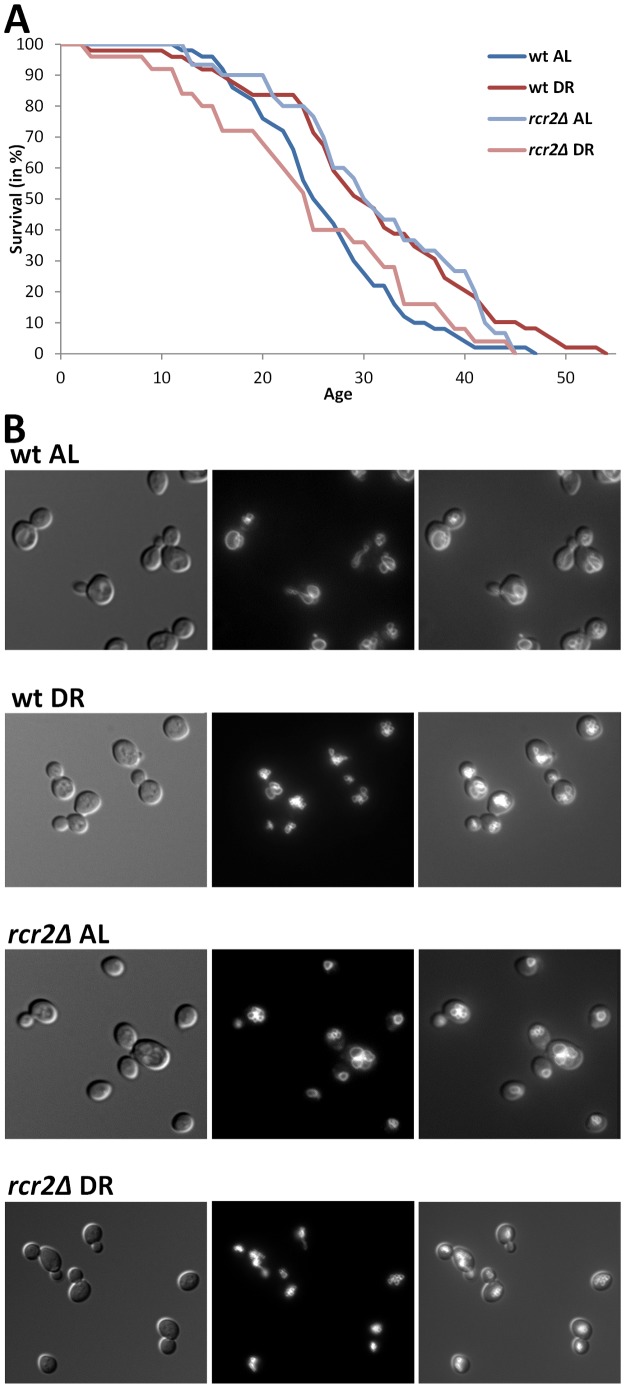
DR–essential vacuole-associated genes are required for DR lifespan extension and normal vacuolar morphology.A, Survival curves of wild-type and rcr2Δ mutant strains measured on AL/YEPD and DR media. The units of age (X axis) are generations. Mean and maximum lifespans as well as sample sizes are listed in Table 2. B, Vacuolar morphology on AL and DR media of wild-type and rcr2Δ. Left panel: DIC images showing the cells; middle panel: TRITC-fluorescent images showing the vacuoles; right panel: overlay of cell and vacuole images.